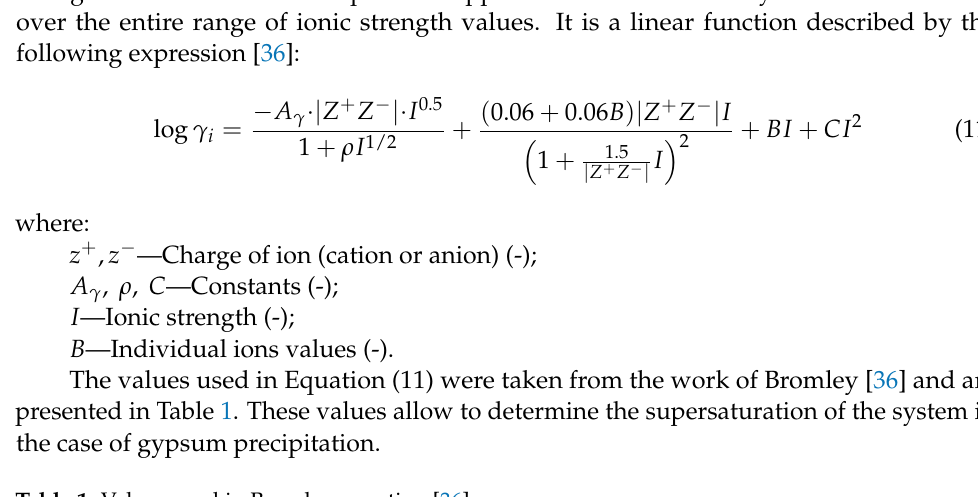
Table 1. Values used in Bromley equation